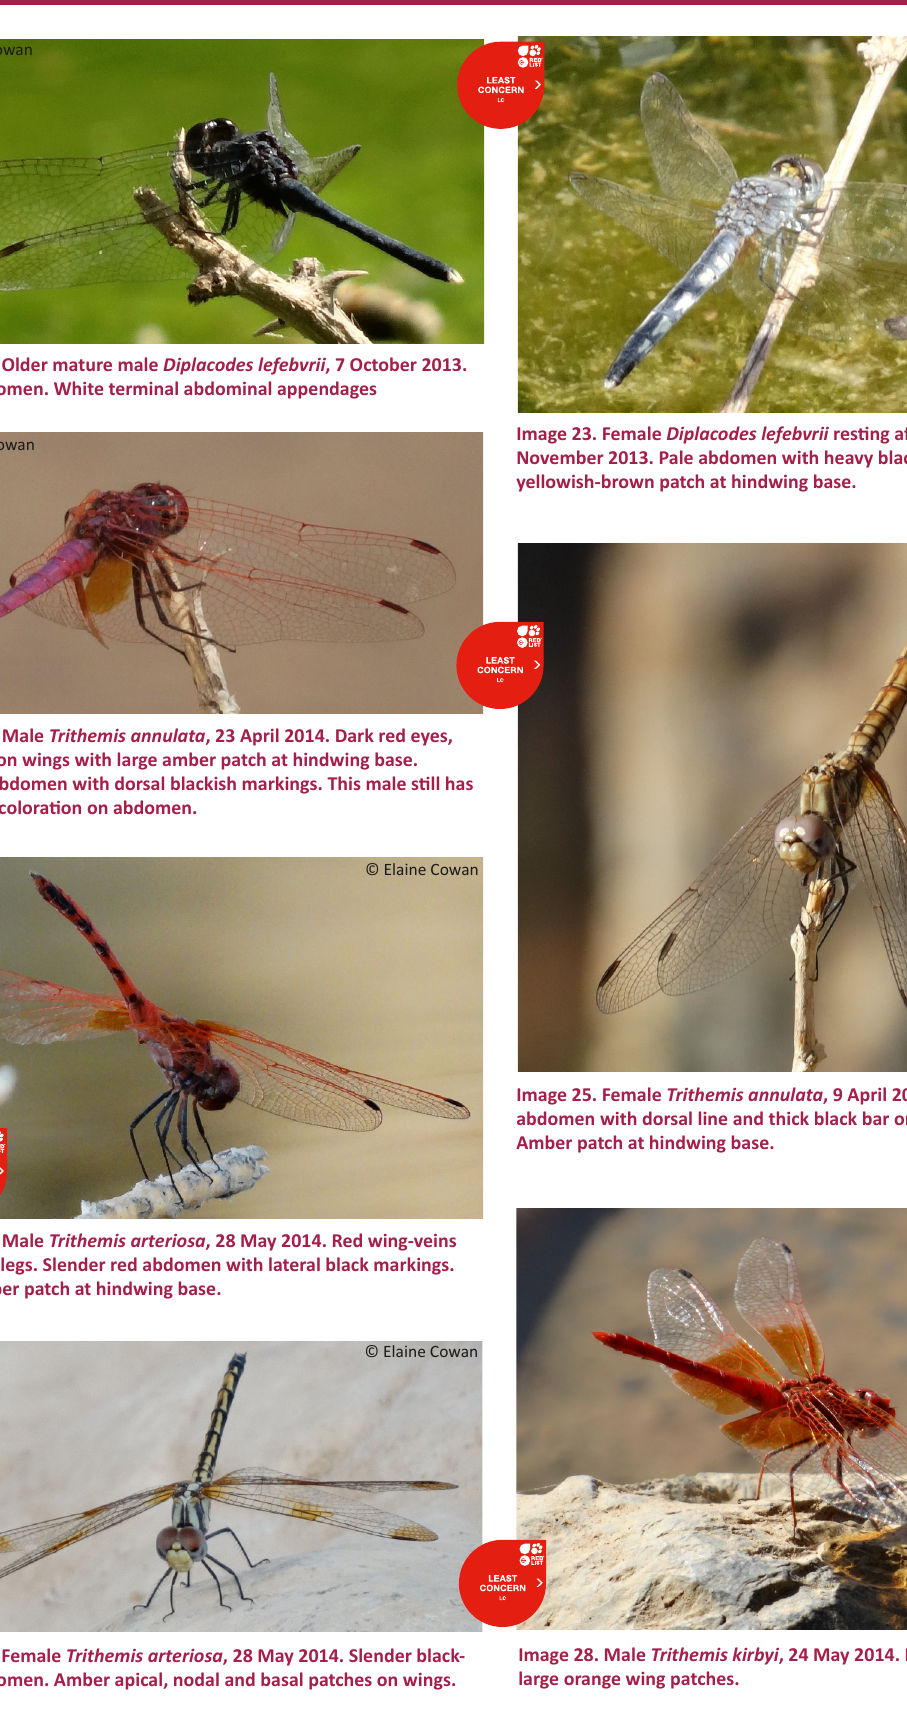
Image 27. Female Trithemis arteriosa , 28 May 2014. Slender black- sided abdomen. Amber apical, nodal and basal patches on wings.